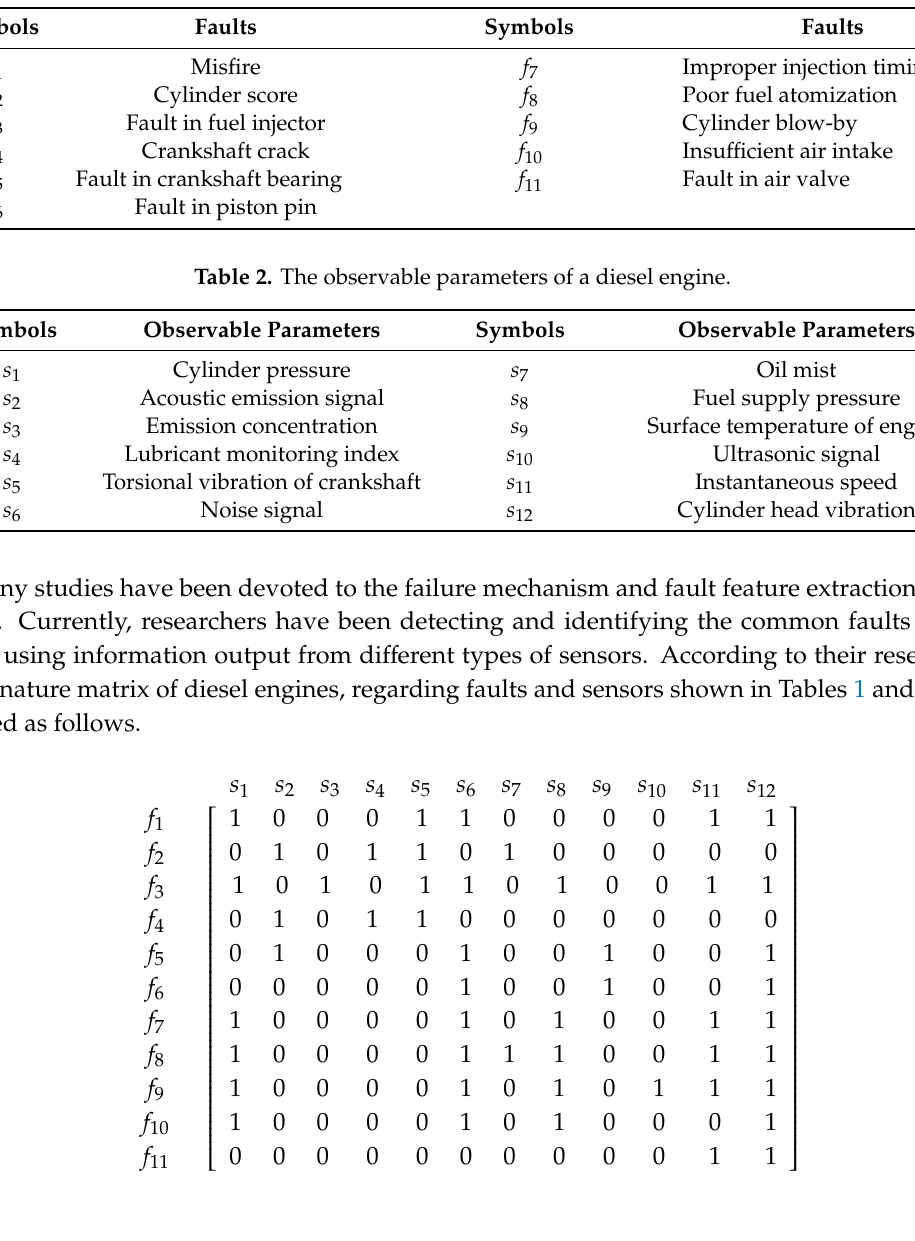
Table 1. Common faults of a diesel engine.